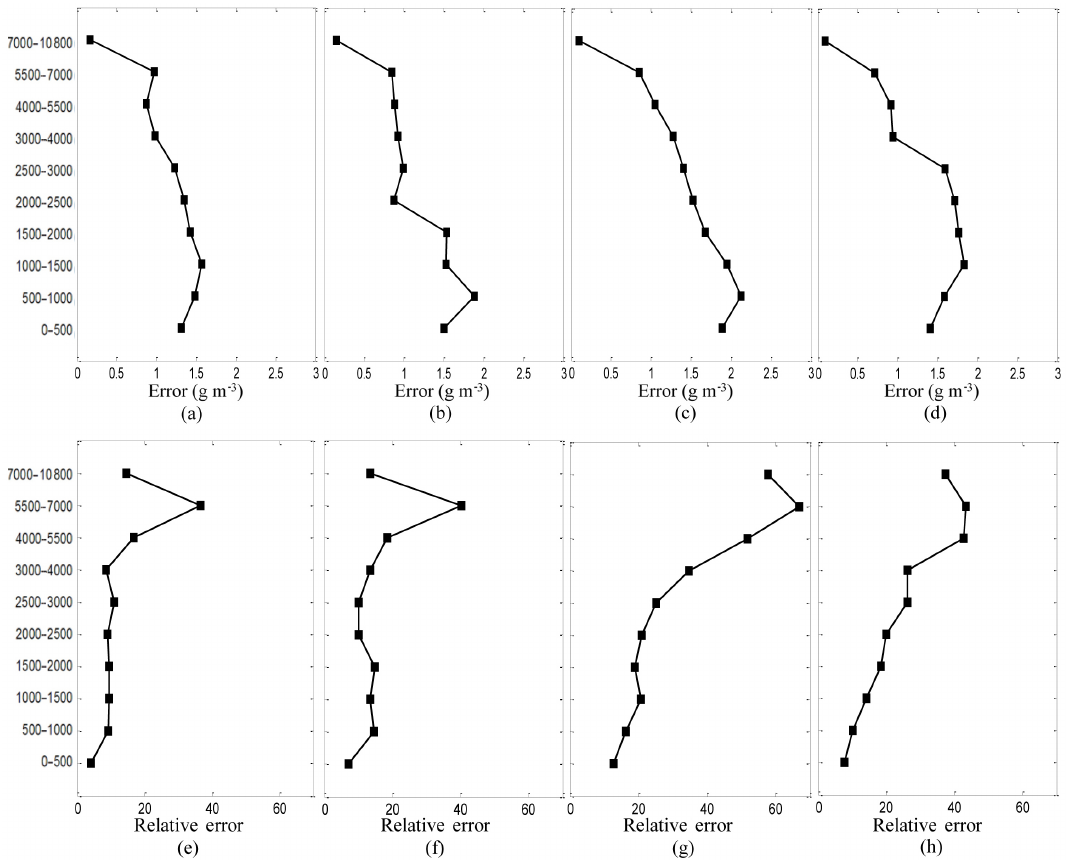
Figure 7. Statistics of the humidity differences between tomographic solutions and radiosonde data in each layer from DOY 221 to 227 2015. (a–d) RMSE and (e–h) relative error of the humidity difference in 10 layers using 4nodes, 8nodes, 12nodes, and constant parameterizations.